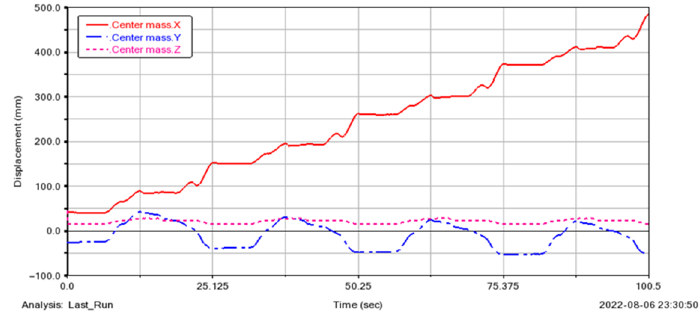
Figure 13. Variance of mass center as the spine swings.